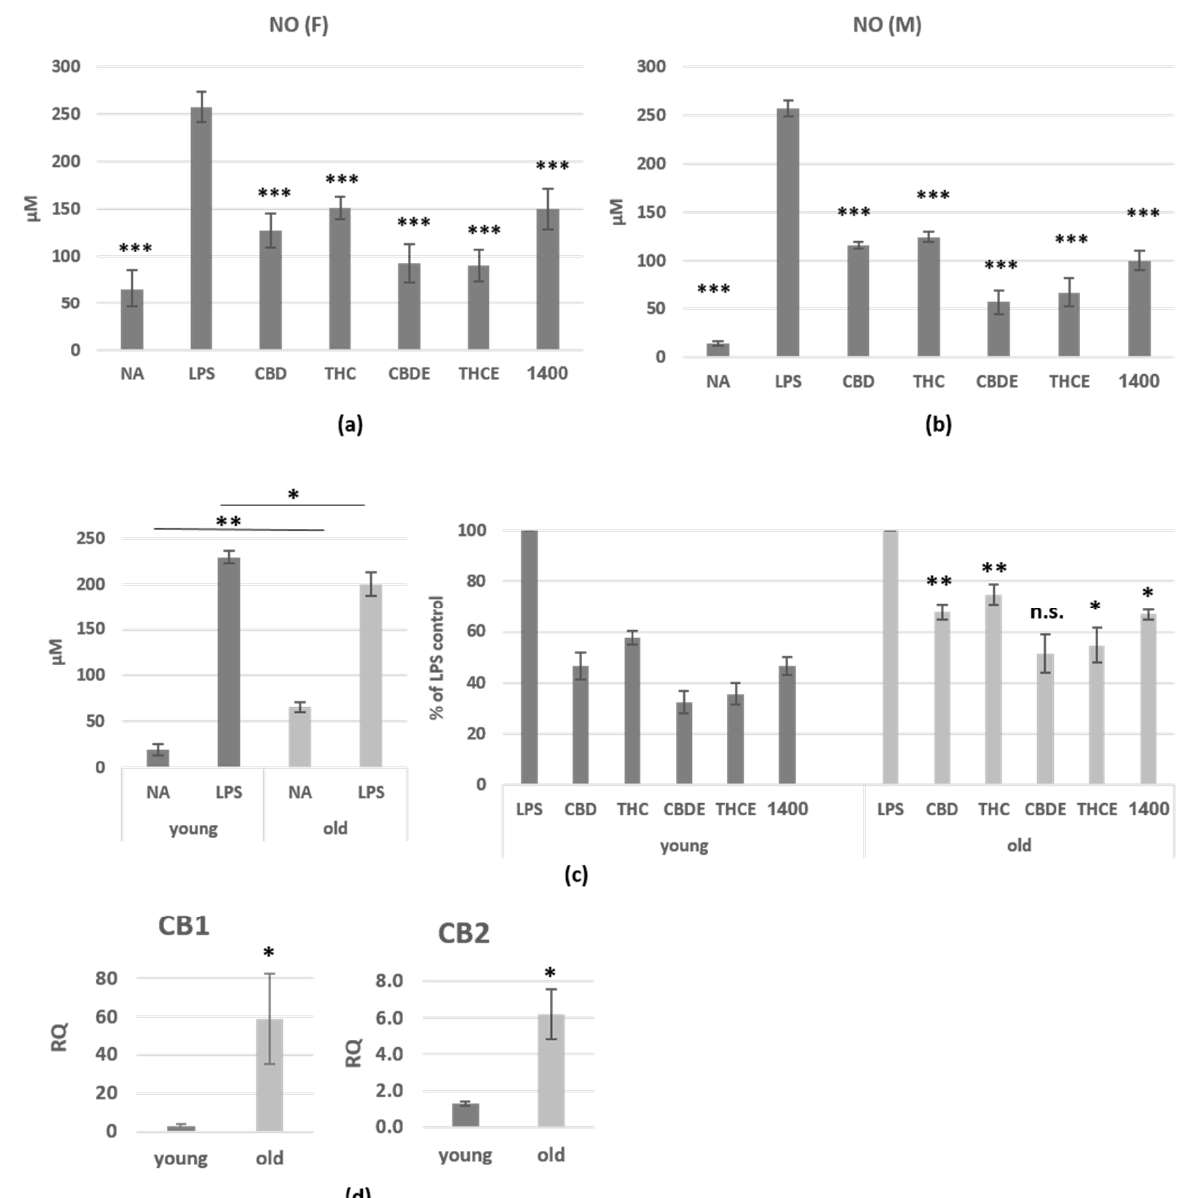
Figure 1. The influence of pure CBD/THC and cannabis extracts on nitric oxide production of LPS-activated peritoneal macrophages. Peritoneal macrophages from C57BL/6 female ( a ) and male ( b ) mice were activated for 24 h with LPS, in the presence of cannabinoid treatments (5 µ g/mL). 1400W (1400), a specific iNOS inhibitor, served as control. NO • levels in the supernatant were analyzed. ( a )— n = 10 mice, from 3 independent experiments; ( b )— n = 7 mice, from 3 independent experiments. The differences of all treatments as compare with LPS-activated control (indicated on the graphs) are highly significant. The differences of THCE and THC between CBDE and CBD are significant in ( a , b ); ( c ) NO • levels in the supernatant of activated peritoneal macrophages from young (2 months old) and aged (18 months old) C57BL/6 female and male mice. n = 7 mice per group, from 3 independent experiments. The differences between aged and young mice in each treatment, are indicated on the graph; ( d ) the expression levels of CB1 and CB2 in peritoneal macrophages from young and aged C57BL/6 female mice ( n = 3/group) were assessed by real-time PCR analysis. The results are expressed as mean + SEM. p -value *, <0.05; **, <0.01; ***, <0.001. NA—non-activated; LPS— lipopolysaccharide-activated macrophages; THC—D9 tetrahydrocannabino; CBD—cannabidiol; THCE—high THC cannabis extract; CBDE—high CBD cannabis extract; n.s.—not